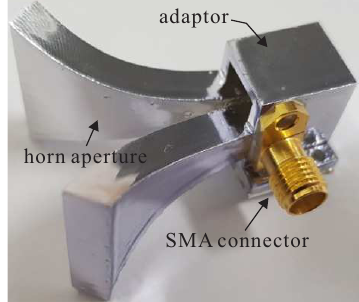
Figure 10. Photograph of the fabricated antenna with dimensions obtained by the robust design procedure.